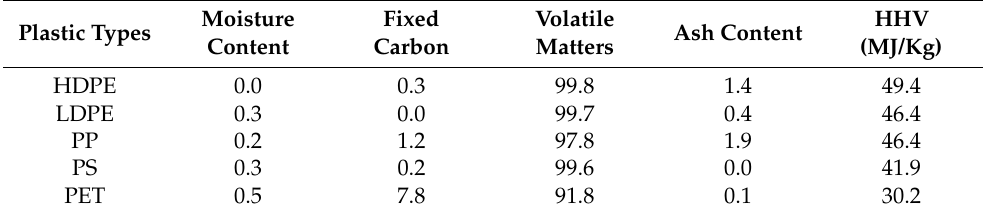
Table 2. Proximate analysis of various plastic types